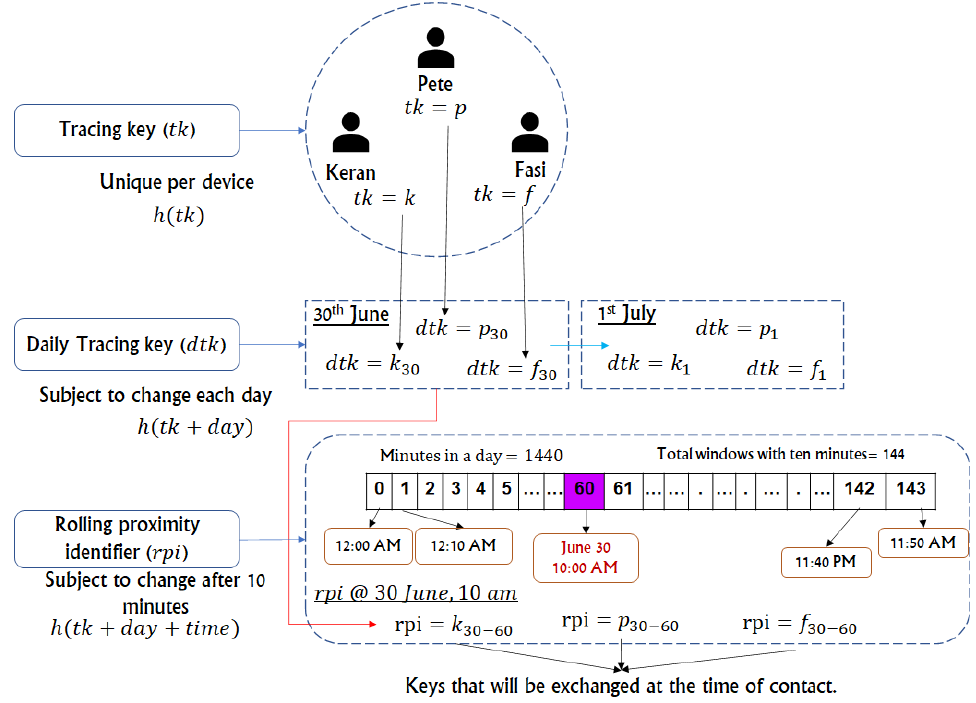
Figure 3. Overview of different keys generation for contact tracing purposes.